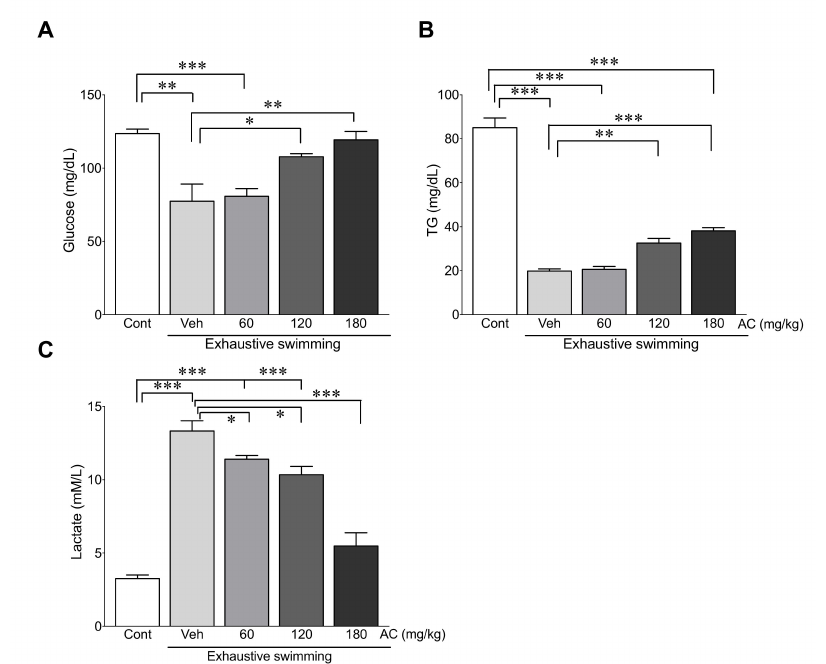
Figure 3. AC extract attenuated changes in energy metabolism-related serum biomarkers from exhaustive swimming. Serum levels of ( A ) glucose, ( B ) TG, and ( C ) lactate were measured in rats after AC pre-treatment for three weeks ( n = 10 per group). Data are mean ± standard error of mean (SEM). Significance was measured using one-way analysis of variance (ANOVA) followed by Bonferroni’s post hoc test. * p < 0.05, ** p < 0.01, and *** p < 0.001. Cont, control; Veh, vehicle-treated; 60, 120, and 180 AC, 60, 120, 180 mg / kg AC extract-treated groups, respectively. AC, Aralia continentalis kitagawa extract; TG,